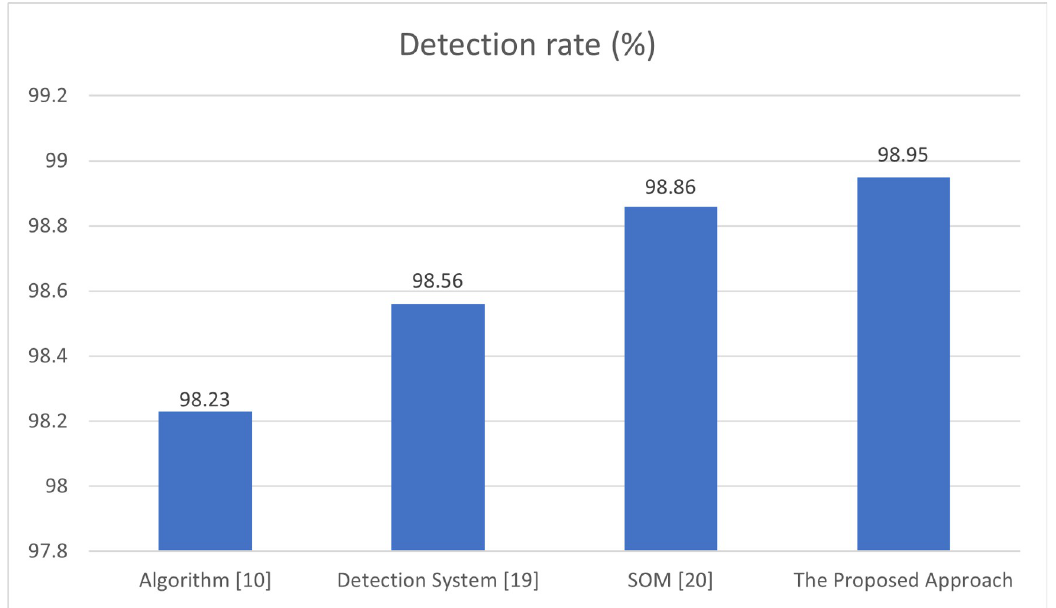
Fig 8. Comparison of detection rate of algorithm [10], detection system [19], detection method [20], and the proposed approach.